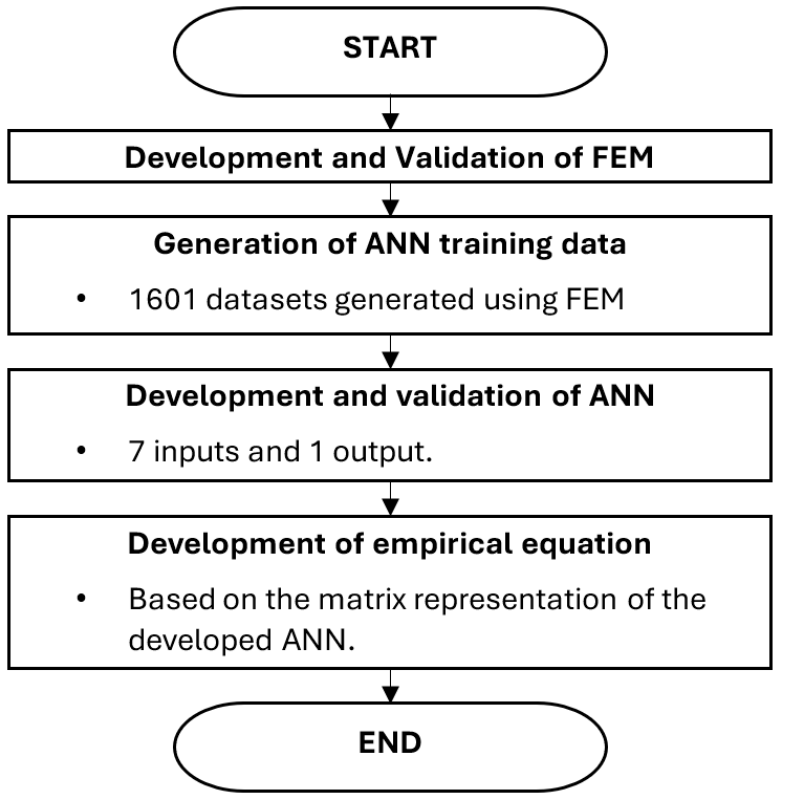
Figure 1. Overview of research fl ow.